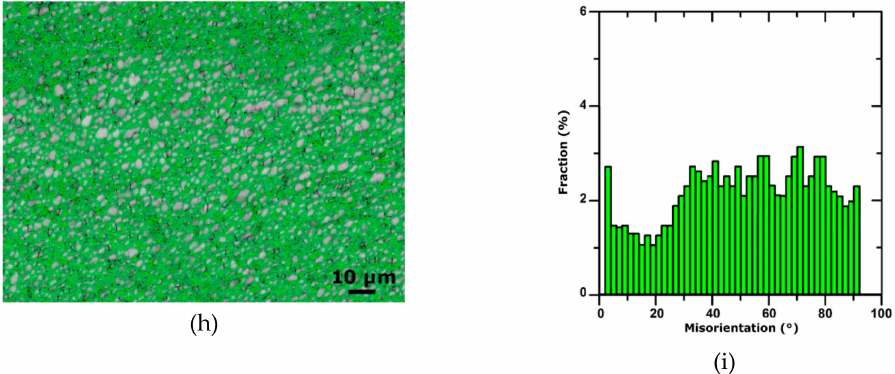
Figure 3. SEM-BSE scan of cast structure ( a ); band contrast electron backscatter di ff raction (EBSD) image with high angle grain boundaries (HAGBs) highlighted in green for samples: RS-ST ( b) ; RS + 400 RPM FSP ( d ); RS + 800 RPM FSP ( f ); RS + 1200 RPM FSP ( h ). Grain boundaries misorientations distributions